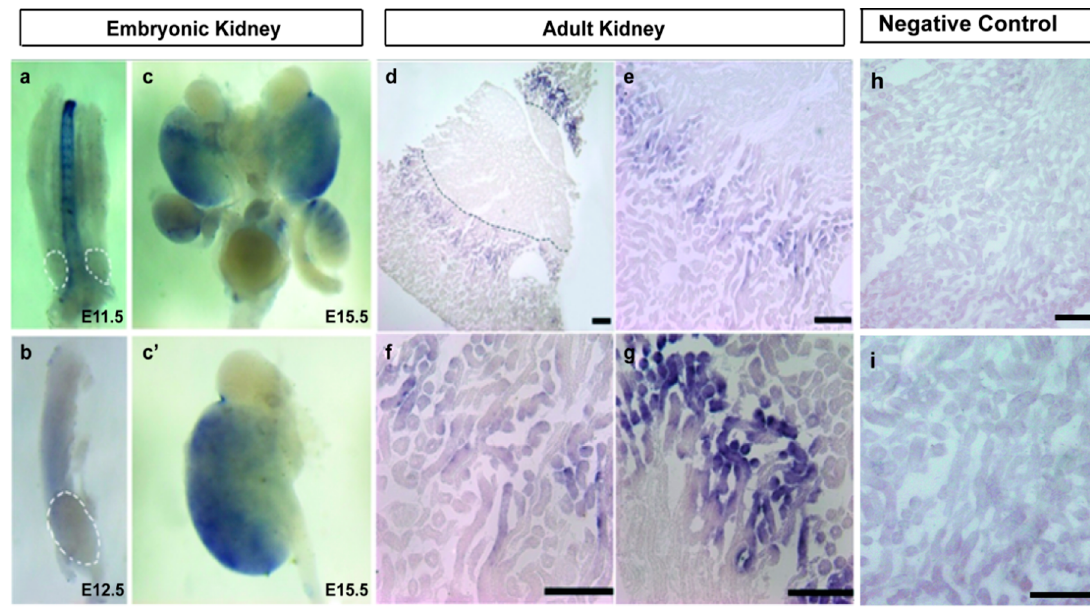
Figure 2. A1CF is expressed in mouse kidney starting at E15.5d and centers on the kidney tubules in C57BL/6 mice . ( a – c ) Whole mount in situ hybridization demonstrates that A1CF is expressed in the later stage of kidney development of C57BL/6 mice . White dot line indicates the area of metanephros rudiment (original magnification, ×40); ( c ′ ) To clearly prove the expression of A1CF, metanephros of embryonic day 15.5 (E15.5d) was detected with original magnification, ×100; ( d – g ) Section in situ hybridization demonstrates that in the adult mice kidney, A1CF is mainly expressed in the tubules of inner cortex but not in the other parts of the kidney section; ( d ) The black dot line marks the boundary between cortex and medulla. Scale bar represents 30 µm; ( e – g ) Images is the amplification of ( d ). ( e ) Scale bar represents 50 µm; ( f ) Image represents the field surrounding kidney tubules; Scale bar represents 100 µm; ( g ) Image represents the field of kidney tubules. Scale bar represents 100 µm; ( h , i ) In control groups no hybridization signal can be detected; ( h ) Scale bar represents 50 µm; ( i ) Scale bar represents 100 µm.